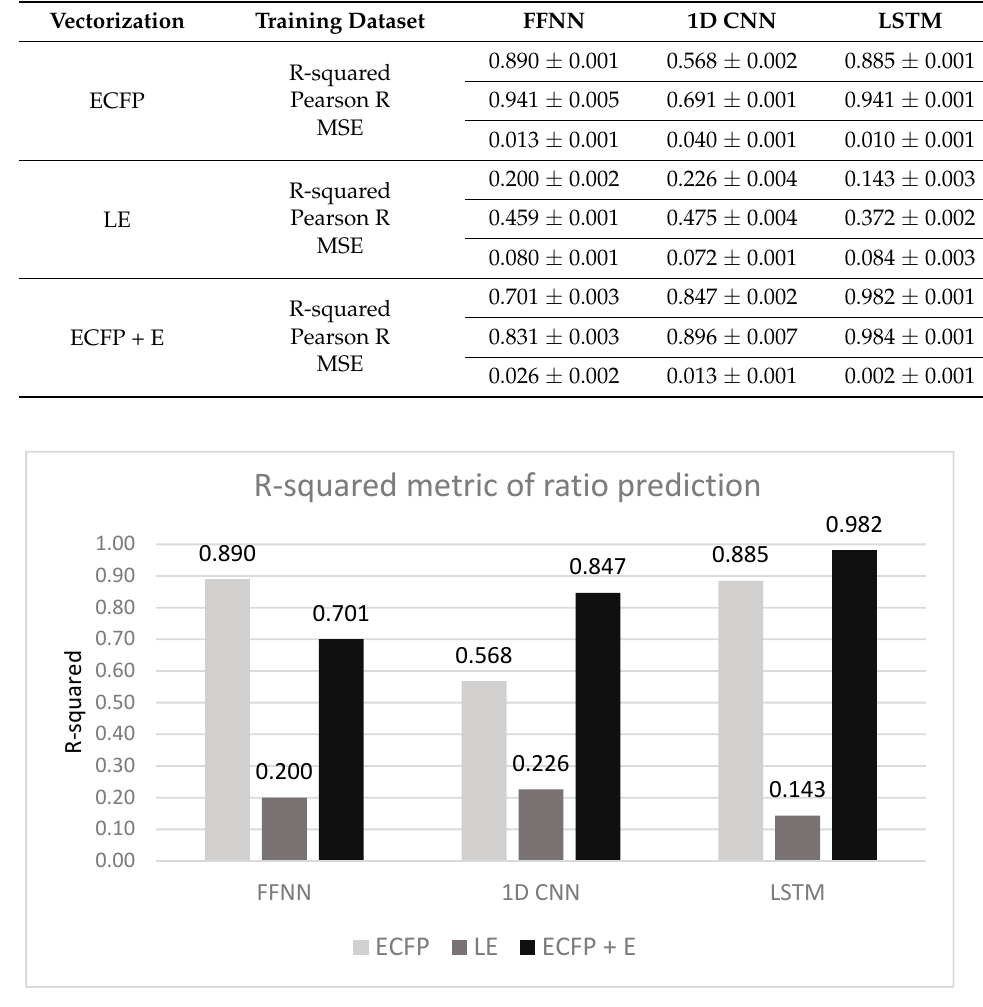
Figure 3. Pearson R values for task No. 2.